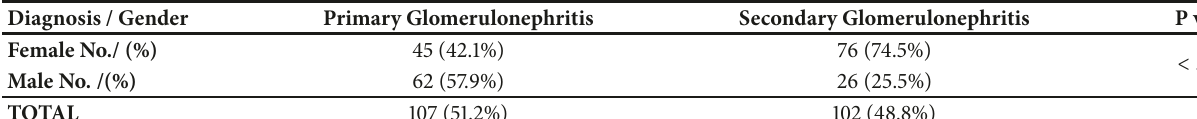
Table 2: Distribution of glomerular diseases based on etiology.